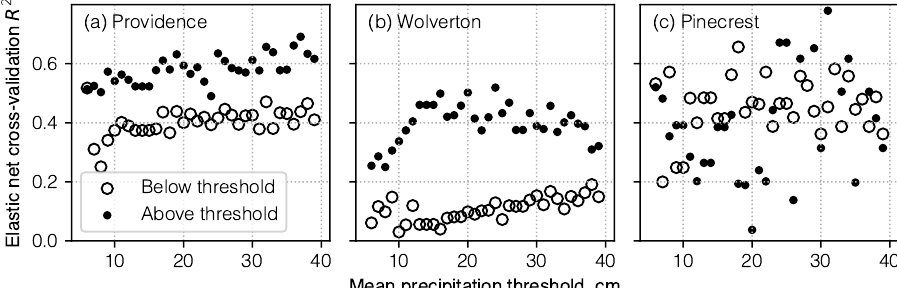
Figure 6. R 2 over three sites vs. mean accumulation across sensors at ( a ) Providence, ( b ) Wolverton, and ( c ) Pinecrest. The analysis were performed by setting a threshold the total precipitation, with regression analysis conducted for events above the precitation threshold and below the threshold, separately.